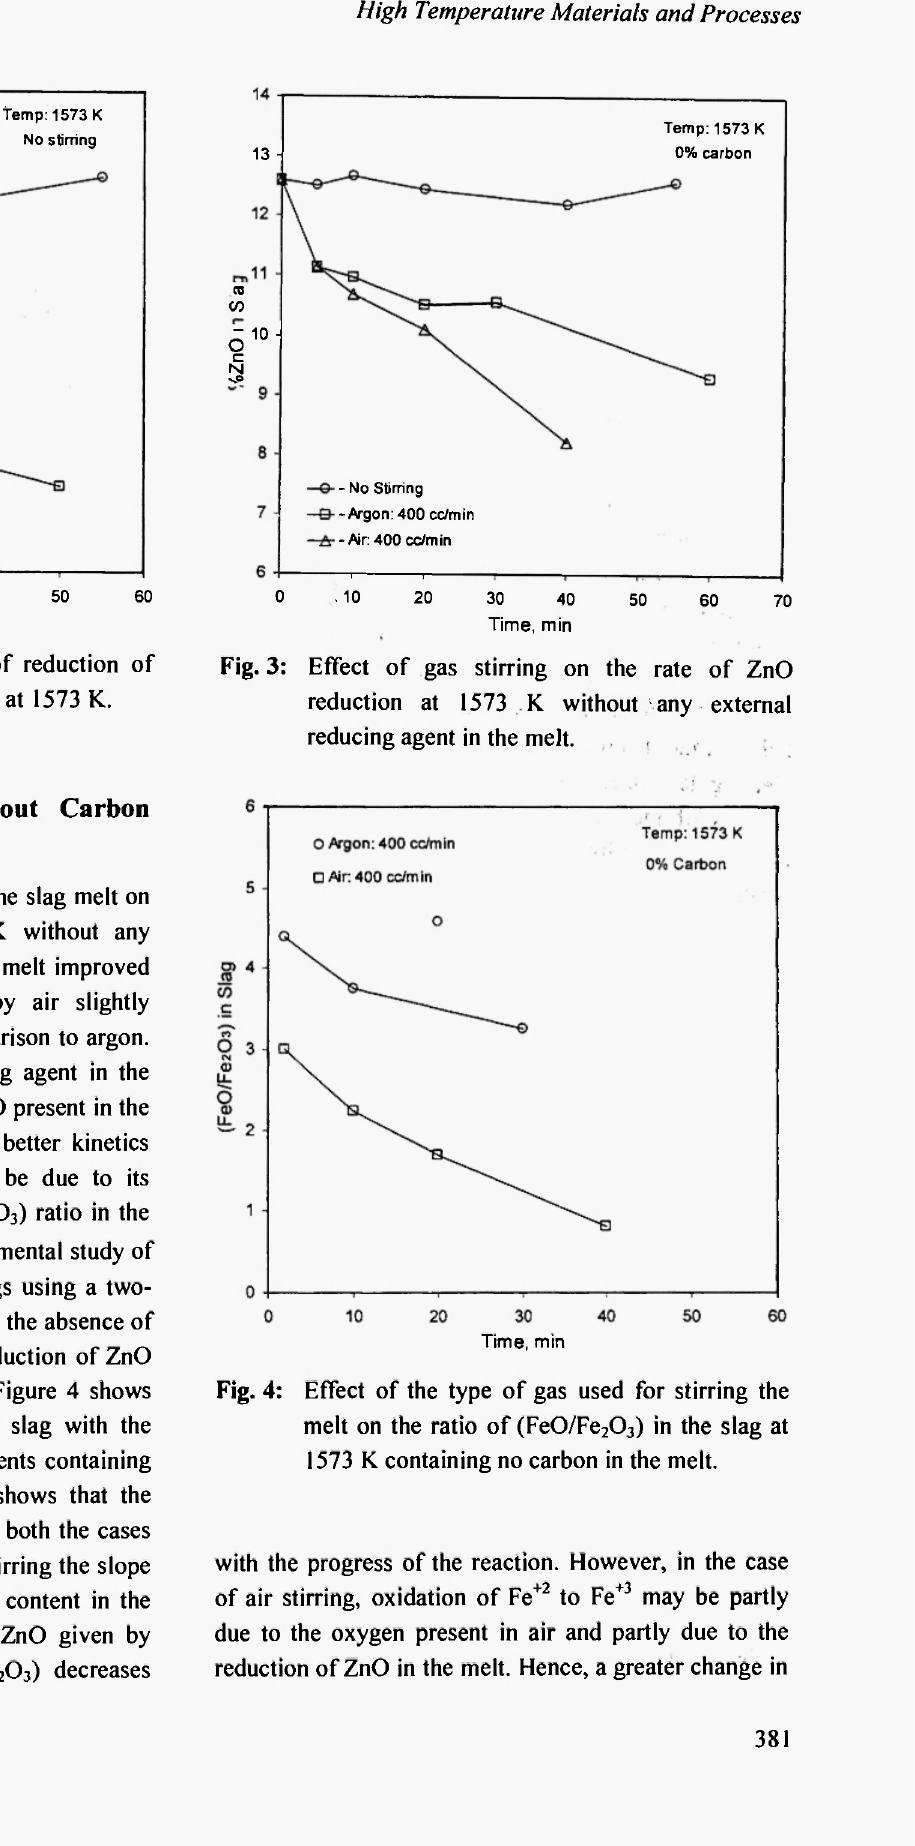
Fig. 2: Effect of carbon on the rate of reduction of ZnO from lead blast furnace slag at 1573 K.